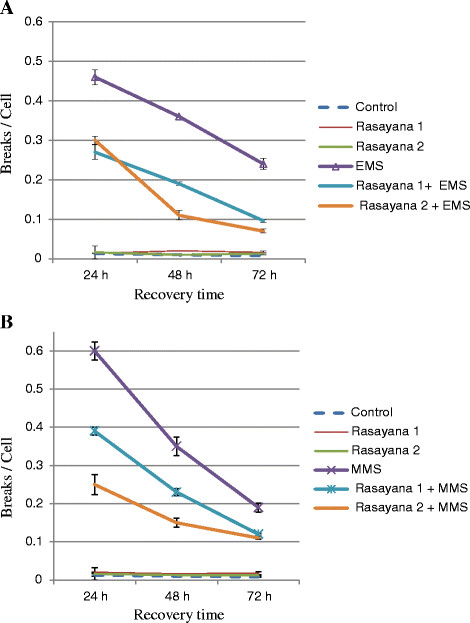
 Chromosome breaks per cell in rasayana and A) EMS- B). MMS-treated mouse bone marrow cells at different recovery times. EMS or MMS alone (positive controls) elicited high frequencies of breaks per cells whereas the animals without any treatment (negative controls) showed very less frequencies of breaks per cells. Rasayana 1 and 2 produced insignificant (p >0.05) breaks per cell compared to controls. The combined treatments of Rasayana1 and EMS; Rasayana 2 and EMS or Rasayana 1 and MMS; Rasayana 2 and MMS showed significant (p <0.05) reduction in the frequencies of breaks per cell at 24 h, 48 h and 72 h recovery times.